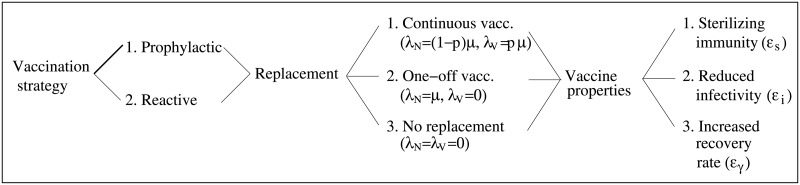
Tree diagram showing modelled scenarios.We refer to the text for definitions of the parameters and further explanations. Here, the vaccine coverage p represents either the proportion of individuals to which the vaccine is administered or the proportion of vaccine responders. Also, delay in the onset of vaccine induced immunity is not explicitly included as vaccine property, as it is equivalent to modelling a reactive vaccination strategy.